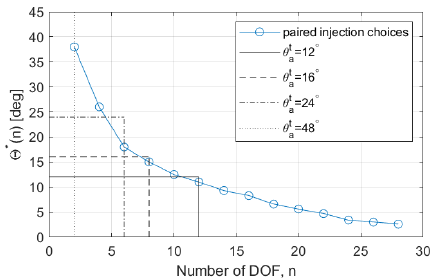
Figure 13. The minimum number of DOFs corresponding to the worst-case error in approximating AOD, θ t a